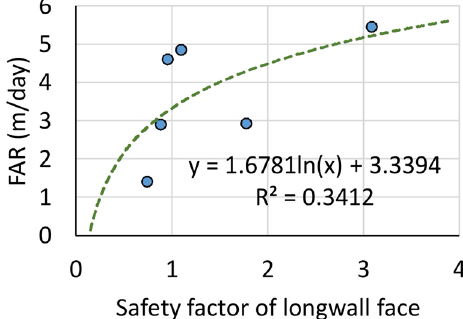
Fig. 6 Comparing the exponential regression with linear regression, from mean of VI’s and FAR in each panel